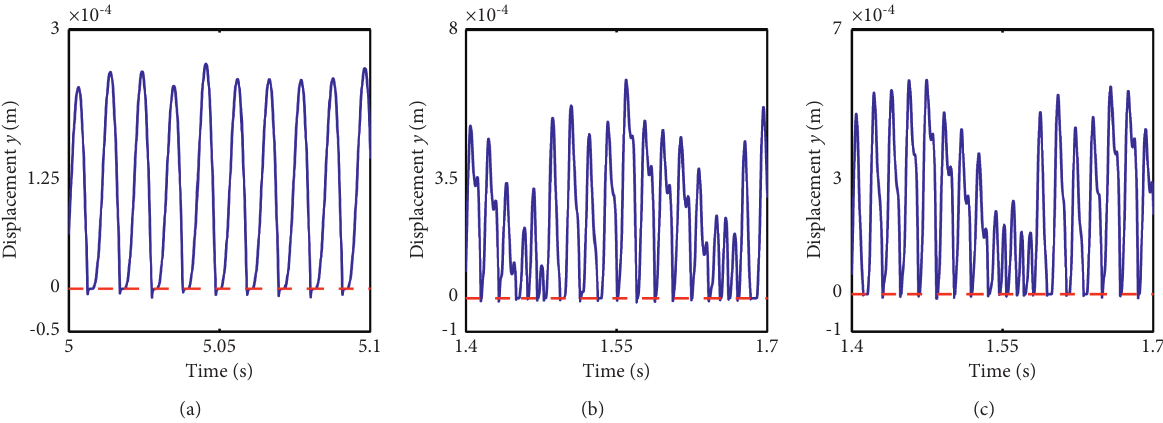
Figure 9: Vibration waveforms of the right bearing support. (a) ω � 5700r/min, (b) ω � 6600r/min, and (c) ω �